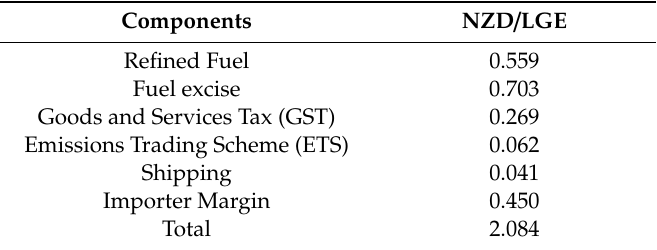
Table 6. Breakdown of petrol price in New Zealand, as of February 2020